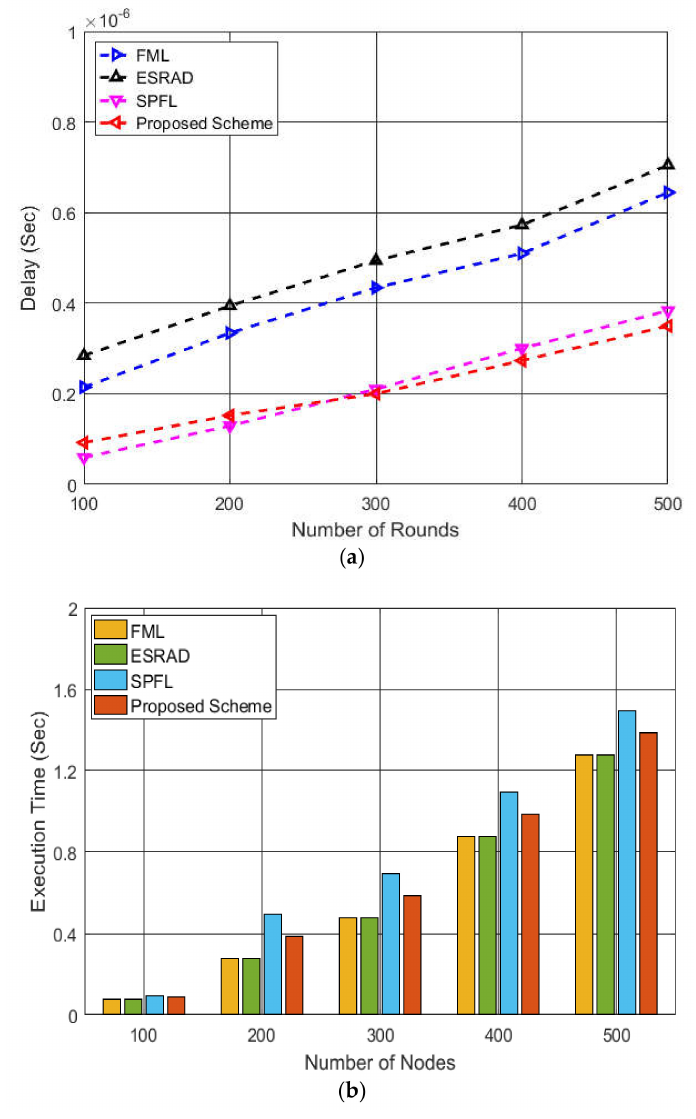
Figure 8. Performance comparison of the four routing algorithms: ( a ) system delay corresponding to specific number of rounds; ( b ) execution time of algorithms with respect to number of